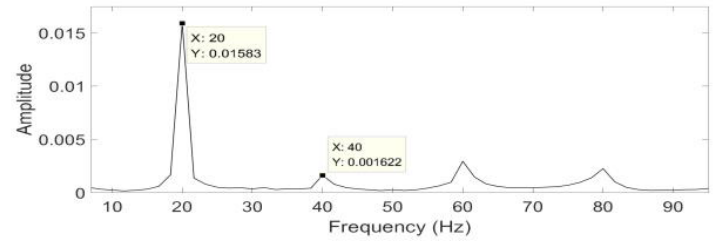
Figure 36. FFT analysis of i gd in PI control system.